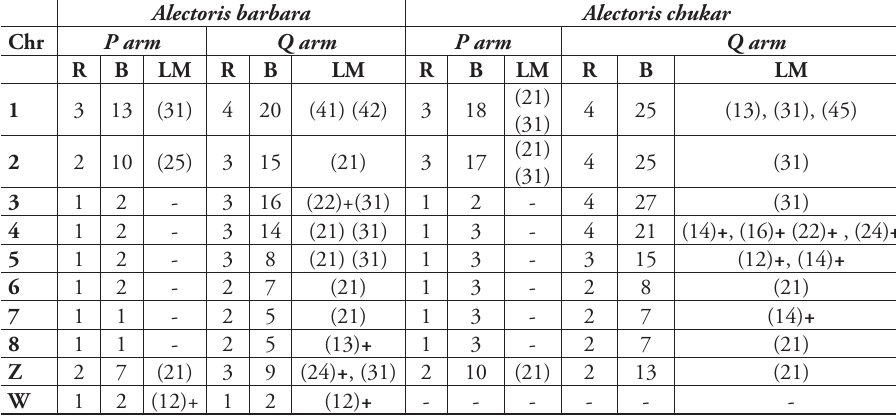
Barbary partridge: one region. 2 RBG bands with a large positive telomeric band. Centromeric region is negatively stained. Table 3. Values summarized from partial ideograms of A. barbara and A. chukar described in RBG/RHG bands. Chr: chromosome, p: short arm, q: long arm, R: region, B: bands, LM: Landmark (all positions show negative landmarks except when (+) is added), empty boxes indicate that there is no particular